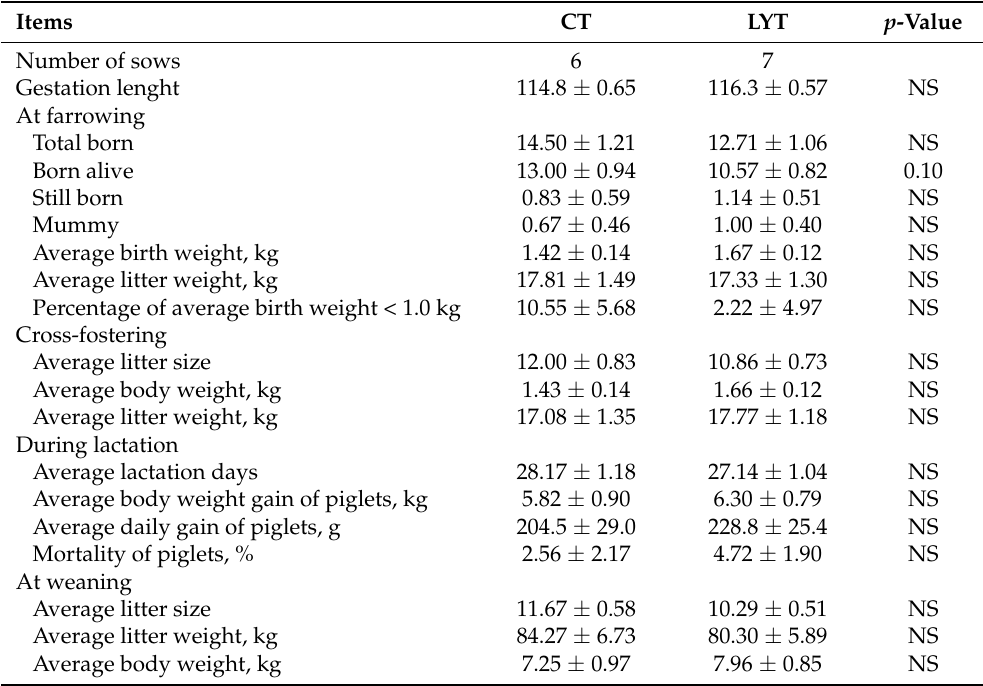
Table 4. The effects of dietary live yeast supplementation during middle–late gestation and lactation on reproduction performance of primiparous